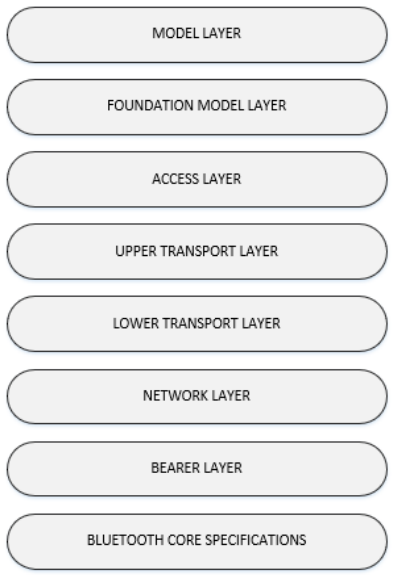
Figure 1. Bluetooth Low Energy (BLE) Mesh System Architecture